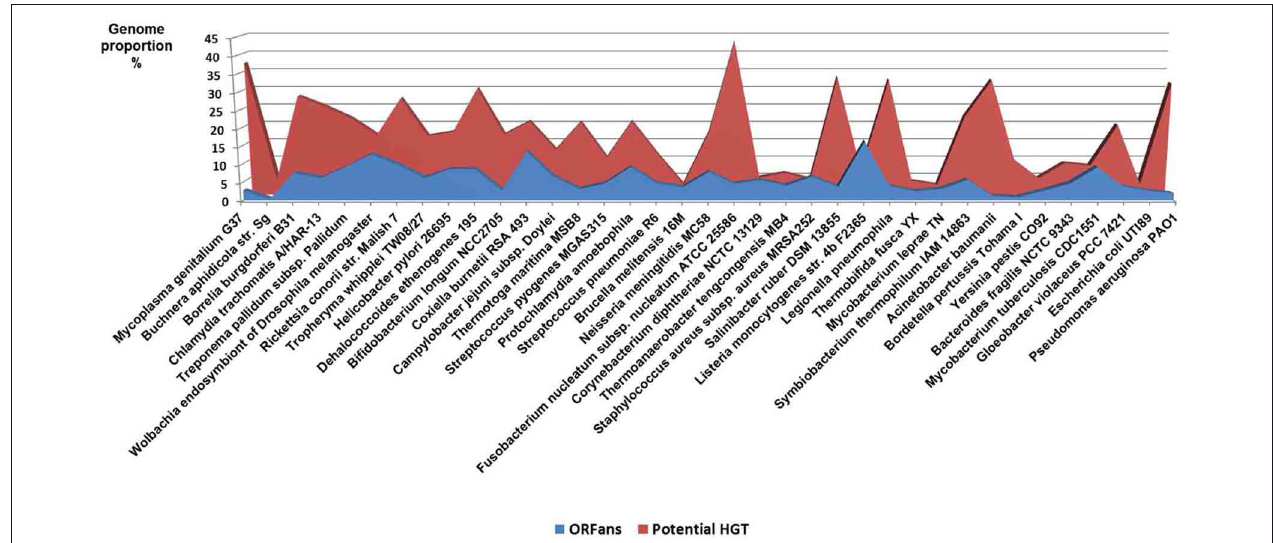
FIGURE 5 | Proportion of the ORFans and potential lateral transfer in bacterial genomes.